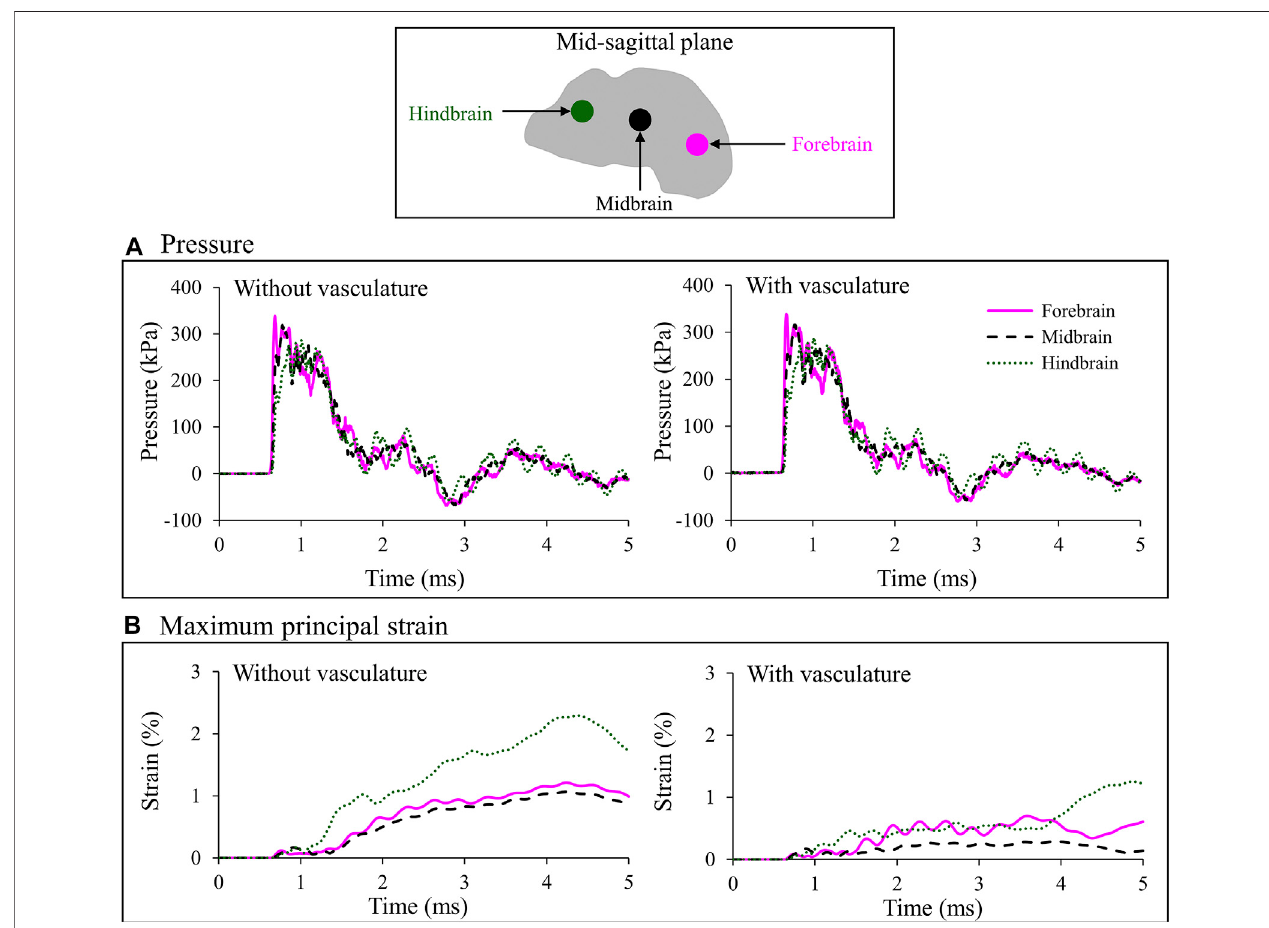
FIGURE 7 | Comparison of the temporal evolution of (A) pressure and (B) maximum principal strain predicted by the minipig-head model with and without vasculatureat three locations(i.e., forebrain,midbrain, andhindbrain)alongthemid-sagittalplane. Locationsare indicatedbycolored circleson themid-sagittalplaneof thebrain.Thesimilarityinthepressurepro fi leforthemodelresultswithandwithoutvasculatureindicatesthatinclusionofthevasculaturedidnotin fl uencetheevolutionof pressure in the brain tissue (A) . In addition, during the initial 1 ms, we observed similar strain predictions for the two models because until that time the blast wave had not yet loaded the head (B) . However, once that happened, we observed a reduction in brain-tissue strain caused by the stiffening of the brain tissue in the model with